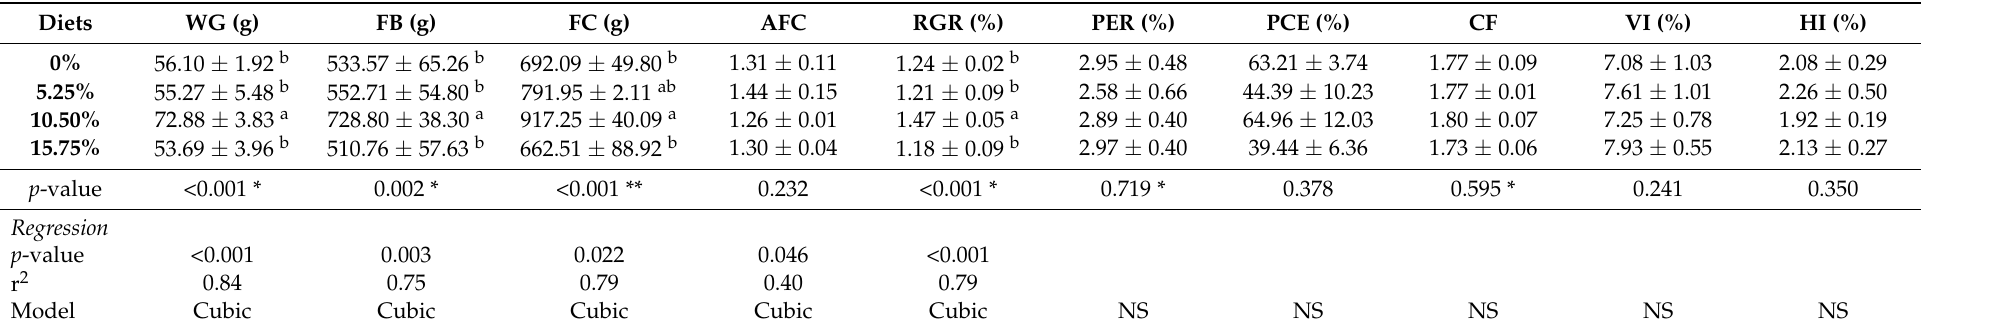
Table 5. Growth performance and biometric indices of tambaqui fed diets containing graded levels of full-fat black soldier fly larvae (FF-BSFL) meal for 60